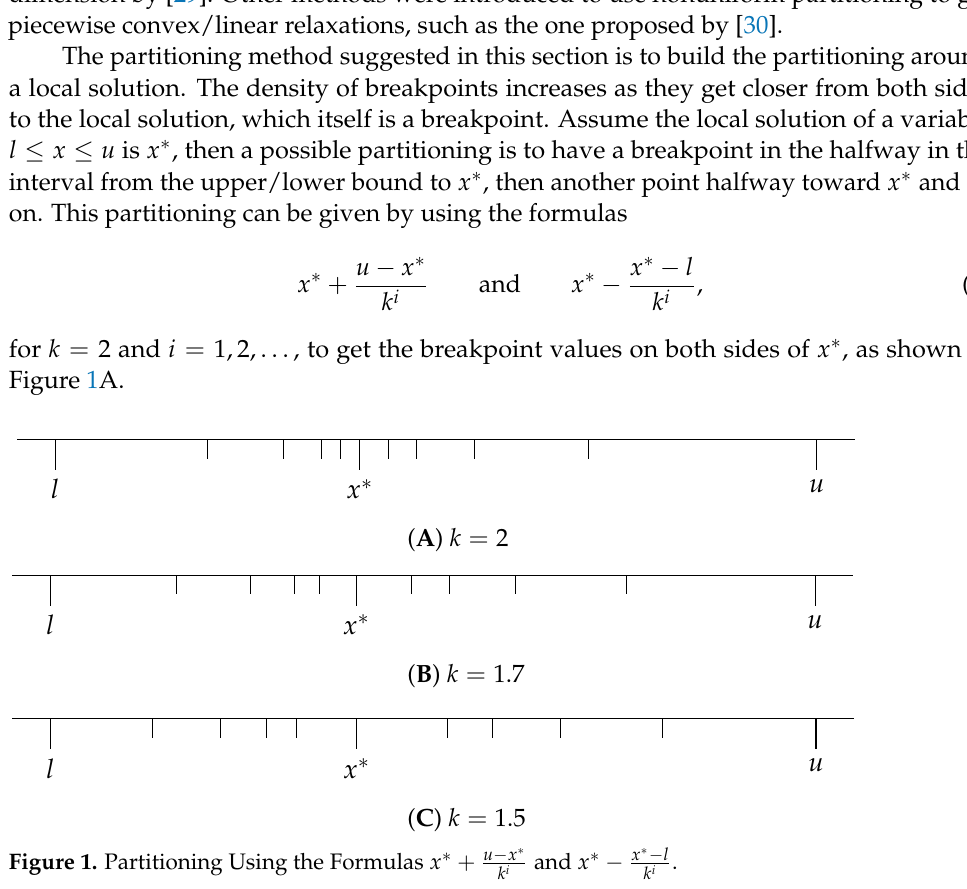
( C ) k = 1.5 x ∗ l and x ∗ − k i k i − x ∗ l and x ∗ . − k i k i − x ∗ l and x ∗ . − k i k i − x ∗ l and x ∗ . − k i k i −